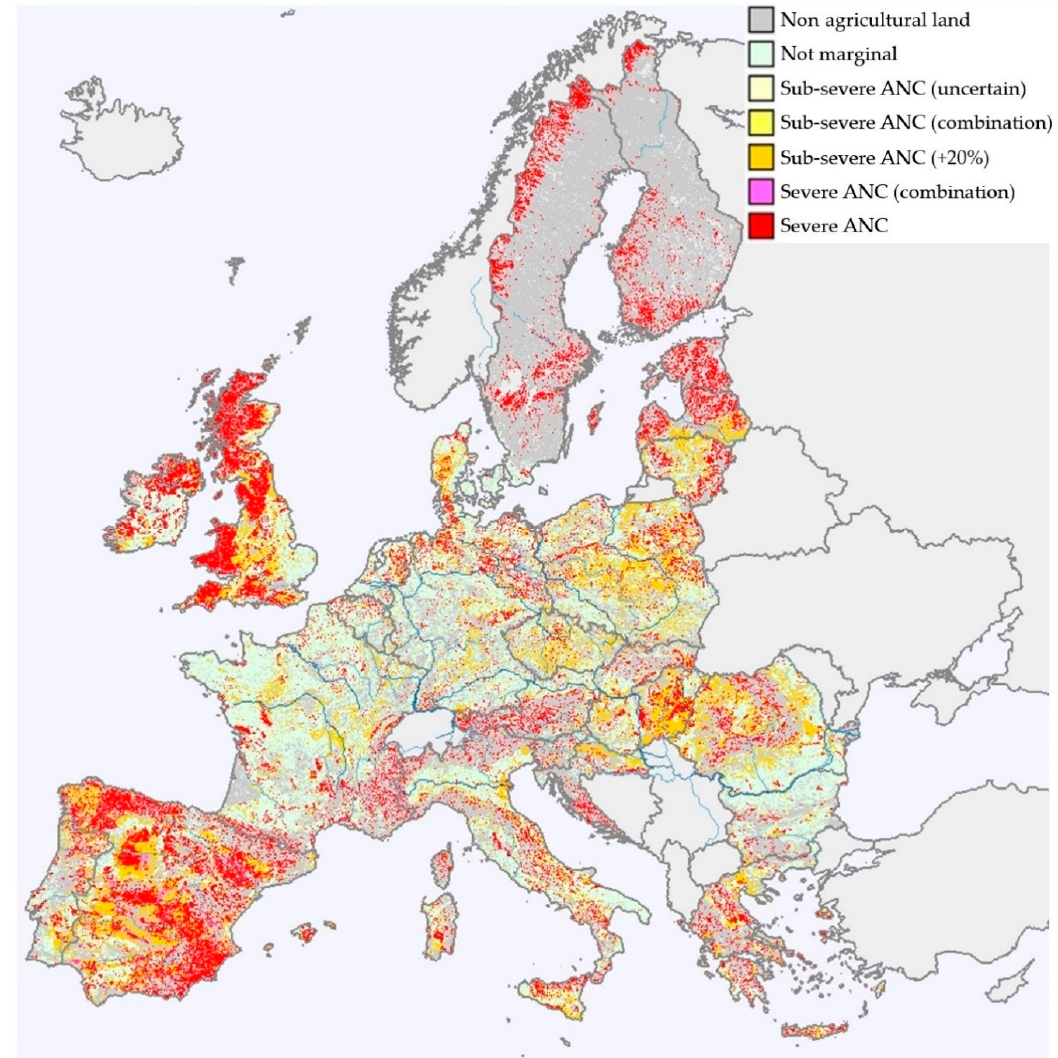
Figure 4. Marginal agricultural lands based on biophysical constraints in Europe (ANC = agricultural natural constraint) (Source: This study).